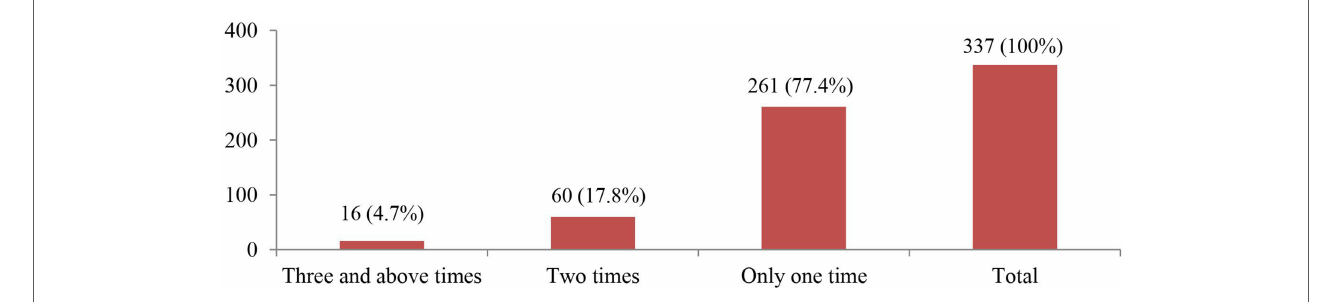
FIGURE 3 Repetition of IPV experienced by the study participant women of reproductive age in Debre Berhan town,